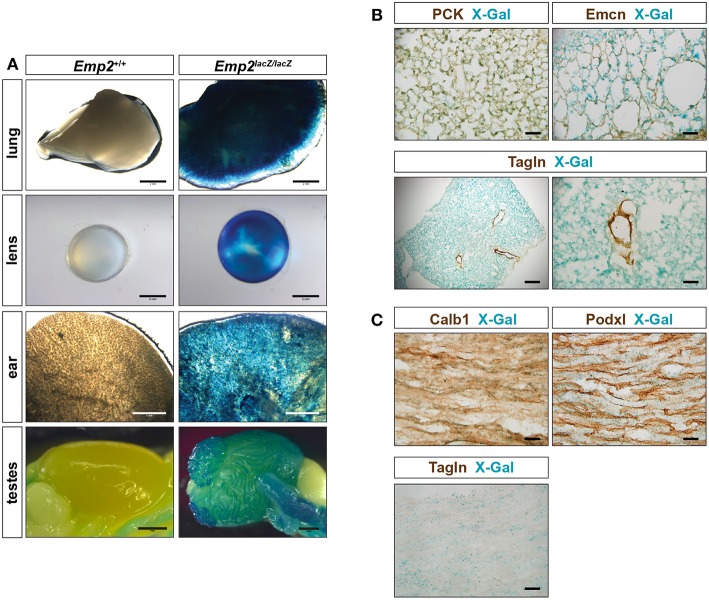
Emp2 is expressed beyond smooth muscles. (A)
Emp2 also has non-smooth muscle expression in other organs. Strong Emp2 promoter activity in Emp2lacZ reporter mice in the lungs, eye lens, ear, and testes. Scale bars: 2 mm, lung and ear; 1 mm lens and testes. (B) Pulmonary expression of Emp2 is primarily in pneumocytes. Emp2 promoter activity (X-gal staining) in the lungs co-localizes with pan-cytokeratin (PCK) immunoreactivity in alveolar epithelial cells (pneumocytes) but not with Emcn (endothelial cells) or smooth muscles (Tagln). Scale bars: 200 μm, lower left; 50 μm remaining. (C) Non-vascular expression of Emp2 in the renal papilla. Prominent Emp2 promoter activity in the renal papilla co-localizes with Calb1 (principal collecting duct epithelia) and not Podxl (endothelial cells), or Tagln (smooth muscle) immunoreactivities. Scale bars: 50 μm.